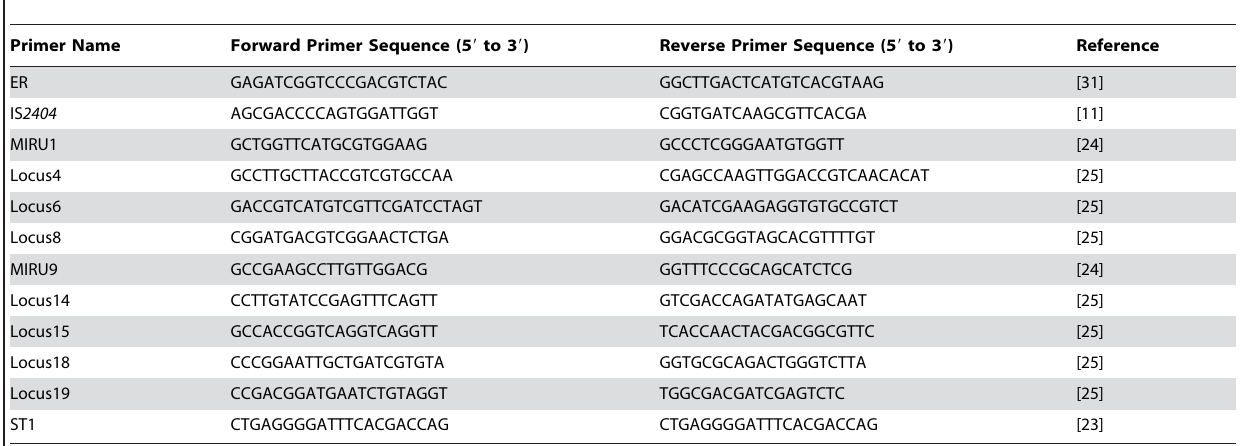
Table 3. Primers used for identification of M. ulcerans in the environment.